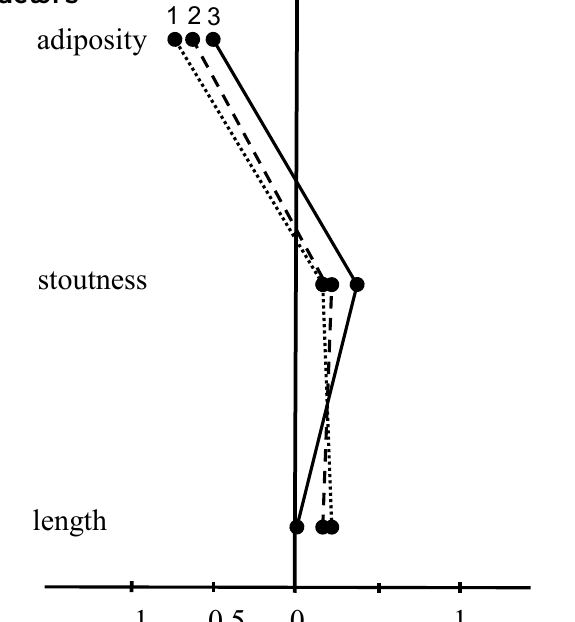
Fig. 1. Natural indicators of body composition factors among baseball players, n = 20. Denotation: 1-pitchers, 2- outfielders, 3-